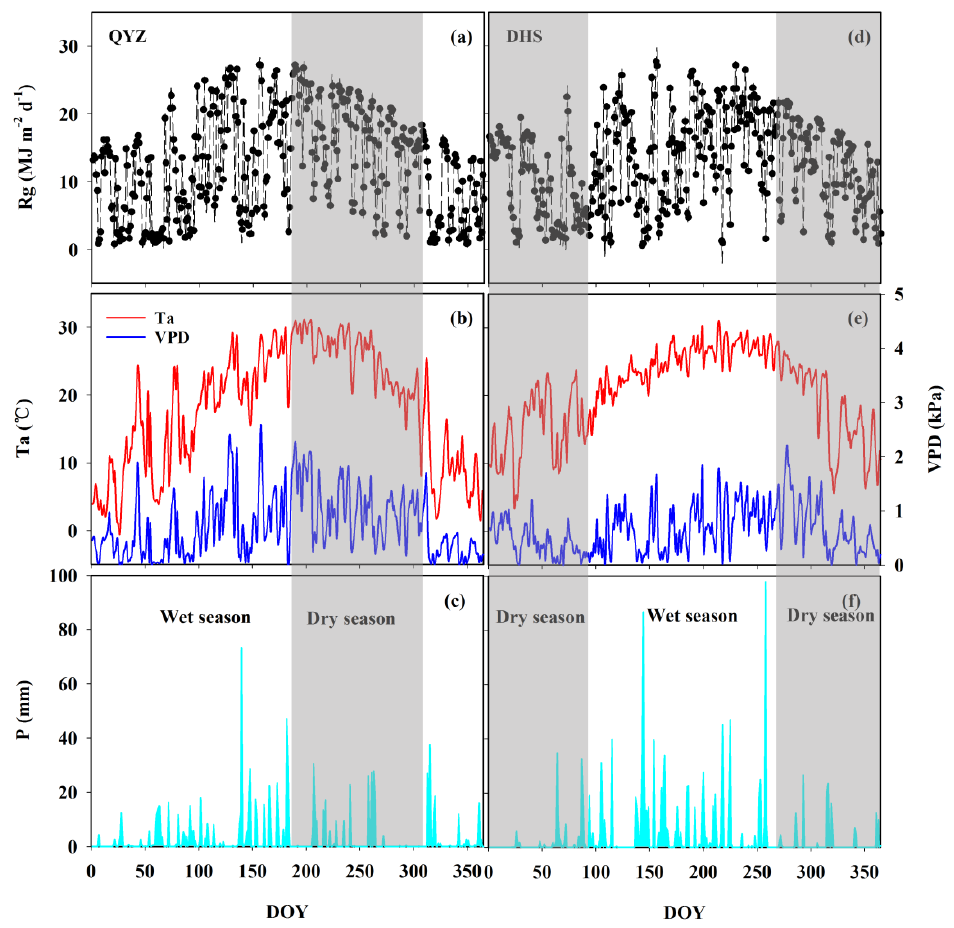
Figure 2. Seasonal variations of meteorological factors at the QYZ and DHS sites. Total solar radiation (Rg) ( a , d ), mean air temperature (Ta) and vapor pressure deficit (VPD) ( b , e ), and total rainfall (P) ( c , f ). DHS, Dinghushan; QYZ, Qianyanzhou.